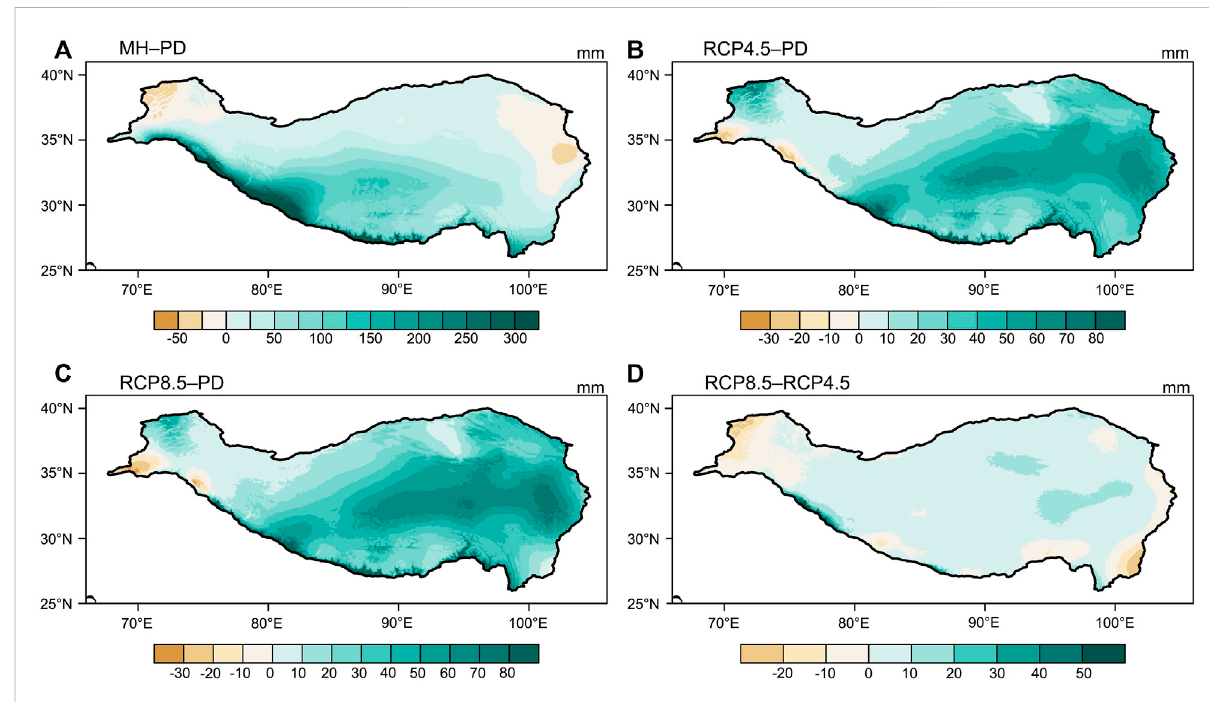
FIGURE 6 Distributionofaverageannualprecipitationdifference(units:mm)acrossTP. (A) MH – PD, (B) RCP4.5 – PD, (C) RCP8.5 – PD, (D) RCP8.5 – RCP4.5.